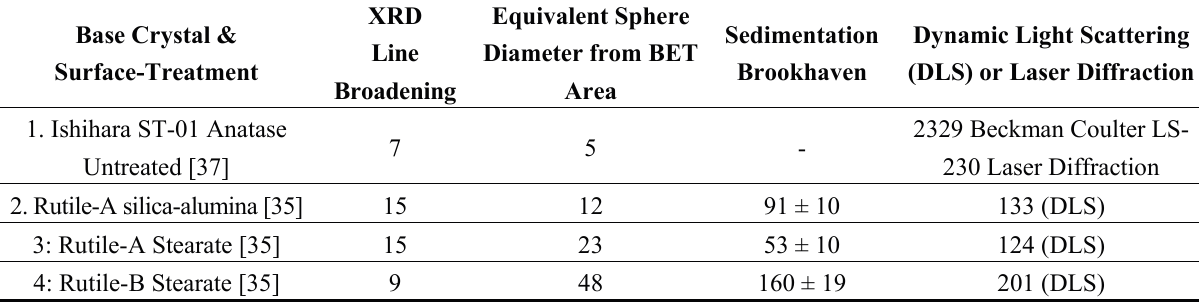
Table 1. A comparison of particle-sizes of nano-particulate TiO 2 measured by X-ray line broadening or by nitrogen adsorption (BET) on the dry powders and by X-ray sedimentation and laser diffraction or laser scattering on aqueous dispersions of TiO 2 . Base Crystal &